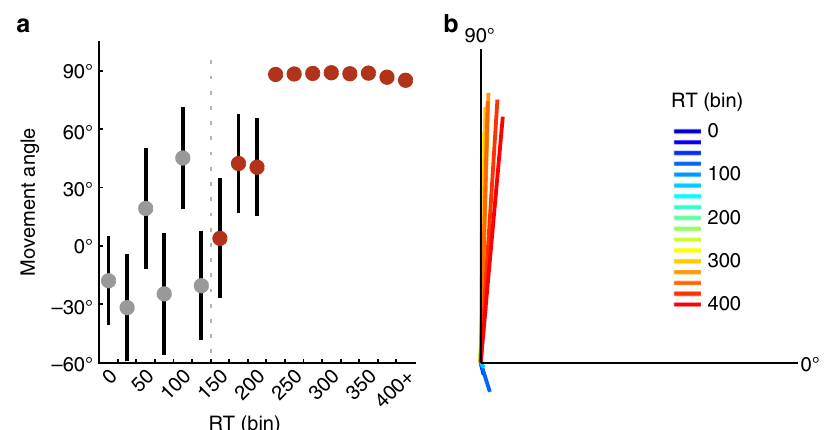
Fig. 6 Experiment 3 results. a Circular mean of movement angles as a function of RT (binned in 25 ms bins) in the 2-target FORCED task ( n = 10). b Pooled vector representation of data in a , where colors represent the associated RT bin (in ms). Error bars represent 1